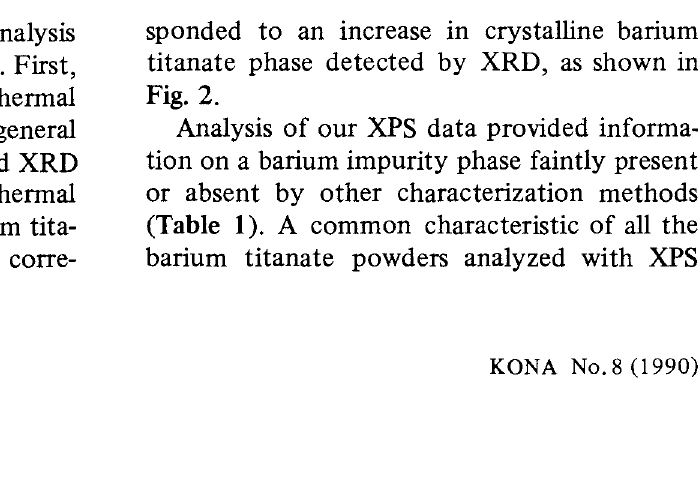
Ba 4d peak, 2) BaTi0 Ba 4d 3 , 512 3 , 312